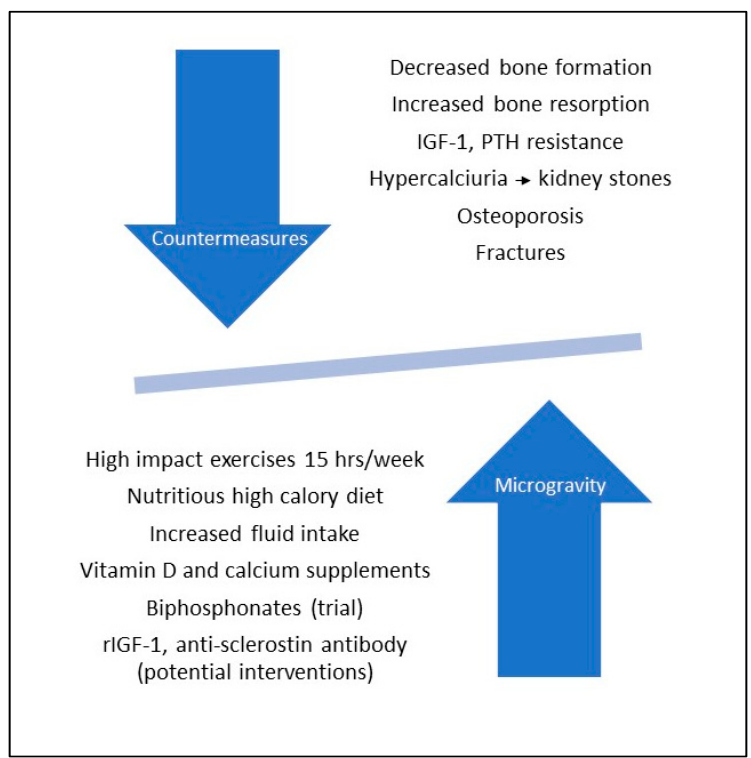
Figure 5. A careful balancing is required to diminish factors that lead to bone loss with interventions designed to maintain bone health during spaceflight.